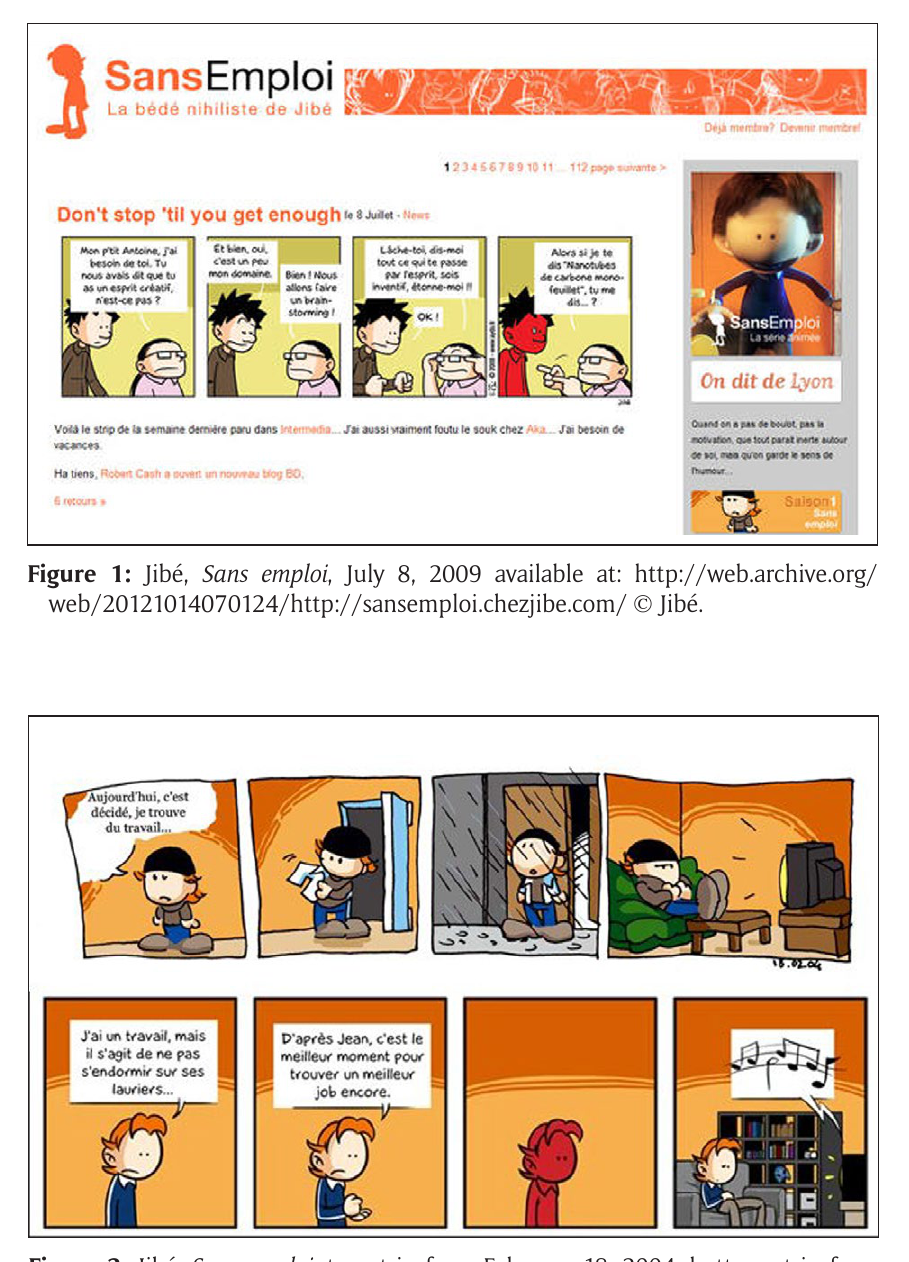
Figure 2: Jibé, Sans emploi , top strip from February 18, 2004, bottom strip from 2010, available at: http://web.archive.org/web/20121014070124/http://sansem- ploi.chezjibe.com/ ©